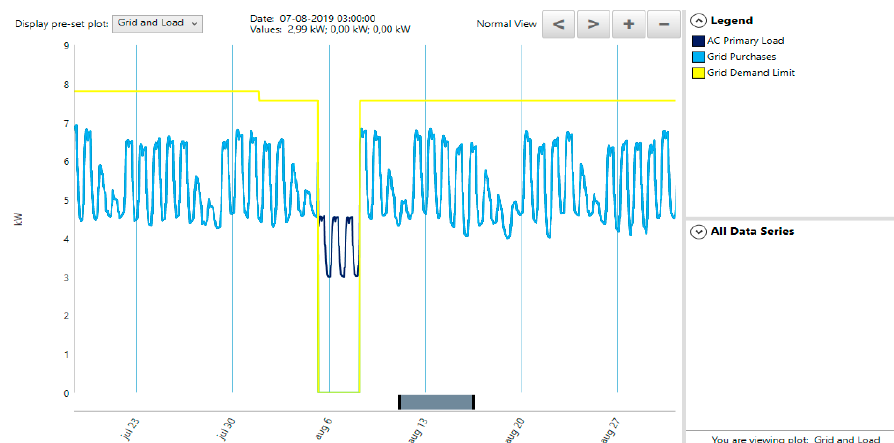
Figure 12. Grid and load for System 1 during an outage.